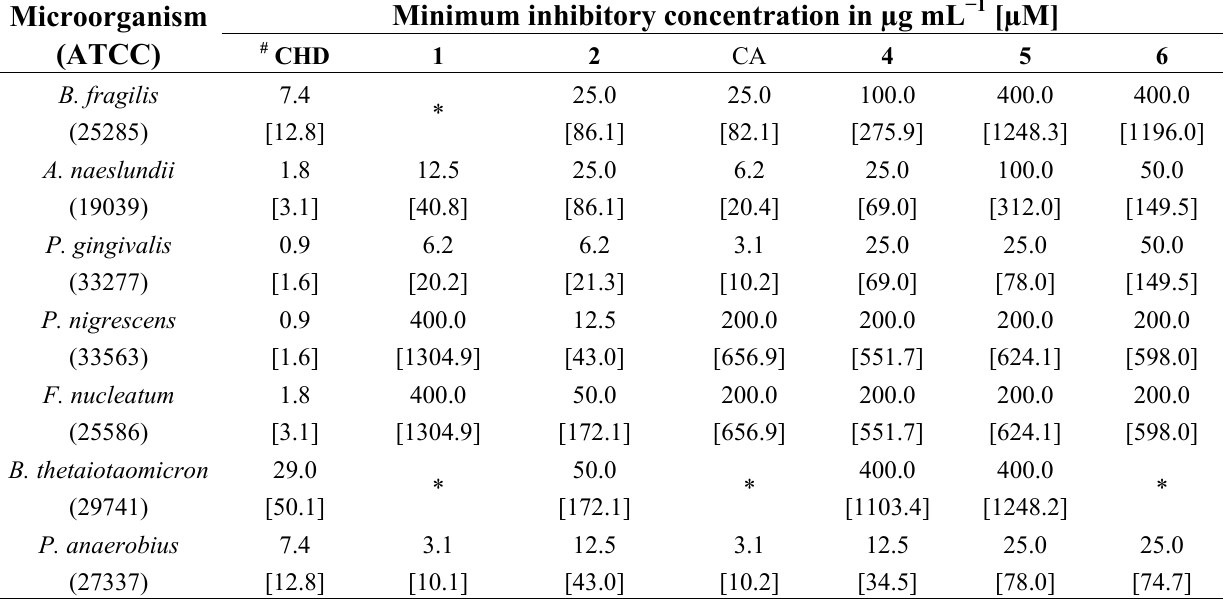
Table 1. In vitro antibacterial actitivity (MIC) of the tested diterpenes against periodontal bacteria.